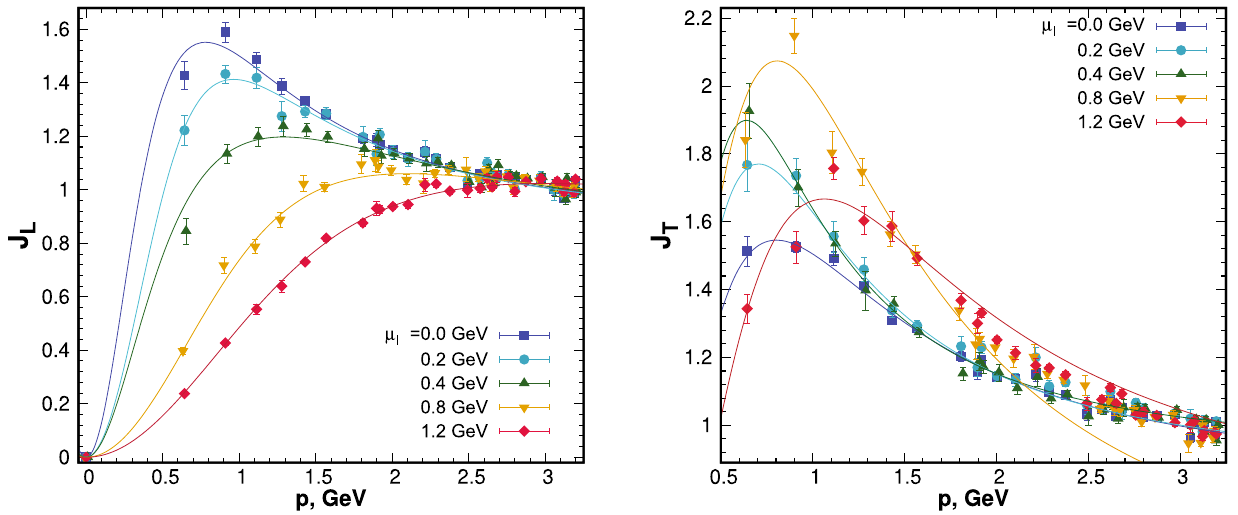
Fig. 7 The longitudinal (left) and transverse (right) gluon dressing functions at various isospin chemical potentials. The curves show results of the fit by